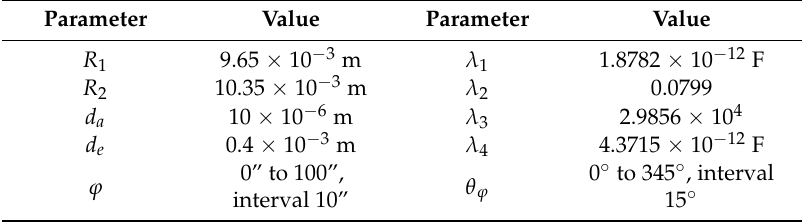
Table 2. Static capacitor model simulation